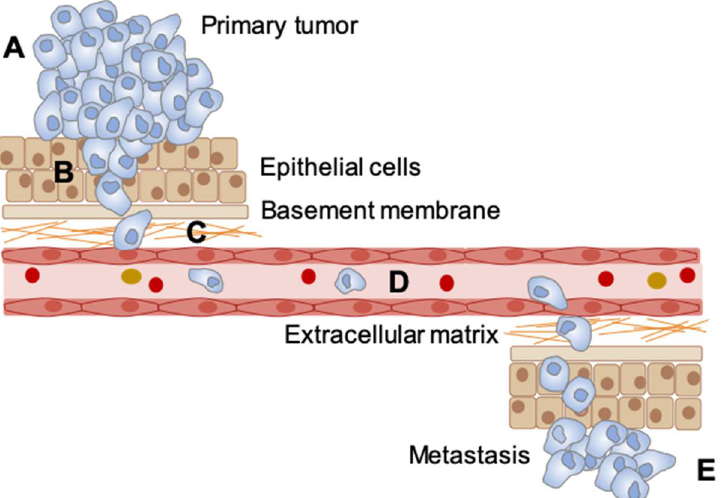
Figure 3. The effect of cyclic hypoxia on different stages in metastasis. ( A ) number of studies have demonstrated that exposure to cyclic hypoxia drives metastasis and importantly, that this occurs at all the key stages of the process. A. EMT/stemness [79 – 81,85,86,88] . ( B ) Invasion/migration [78,80–82,84] . ( C ) Modulation of the extracellular matrix (ECM) [160] . ( D ) Survival in blood circulation [89]. ( E ) Proliferation in target organ [86,89,99,103–106,159] .